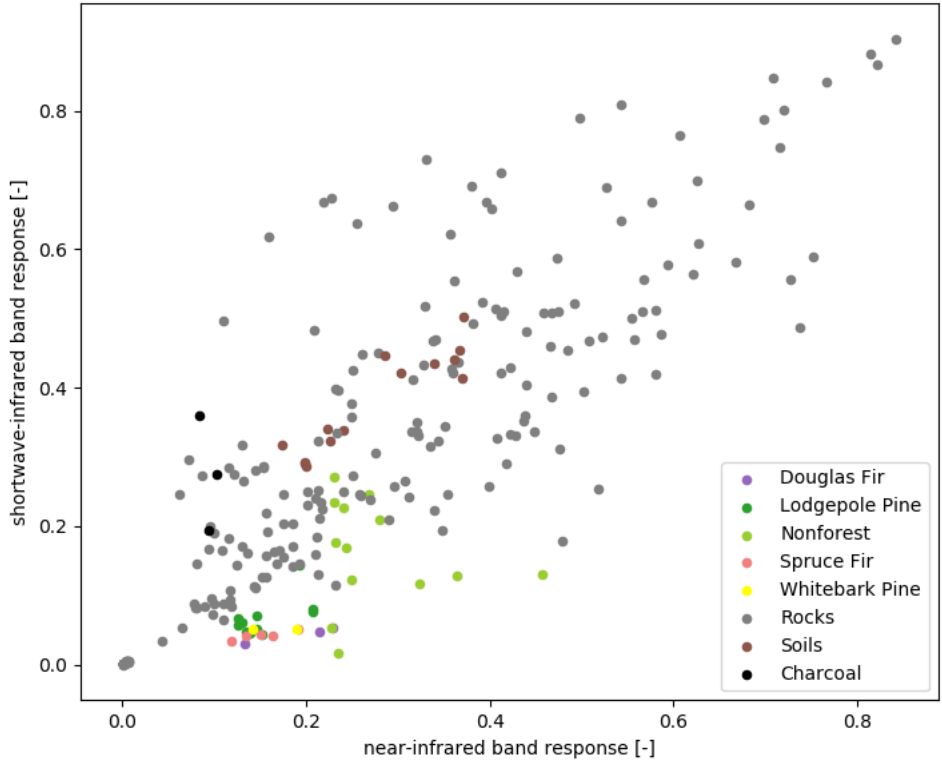
Figure 1. Near-infrared (NIR) and shortwave infrared (SWIR) band responses of Landsat 8 for the endmember